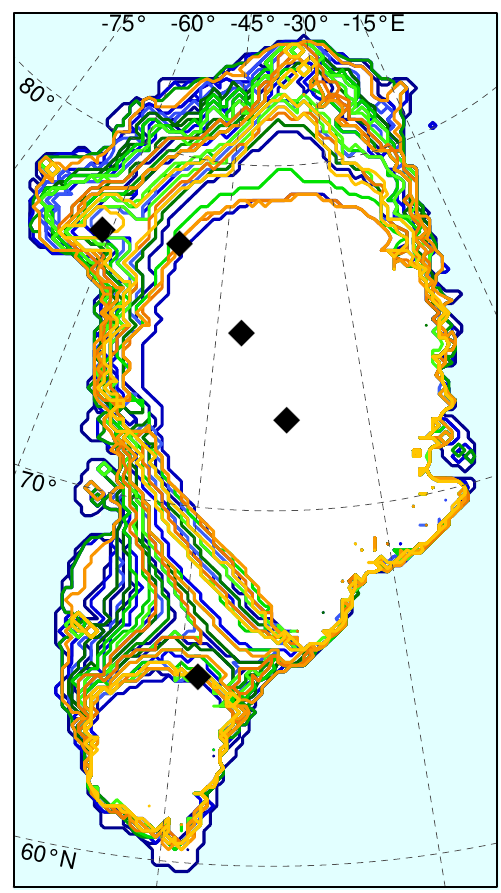
Fig. 8. Eemian minimum ice margin contours for the 46 accepted simulations. The colors correspond to the choice of parameters (as in Fig. 6). The black diamonds show the locations of ice core drill sites (from South to North: DYE-3, GRIP, NGRIP, NEEM and Camp